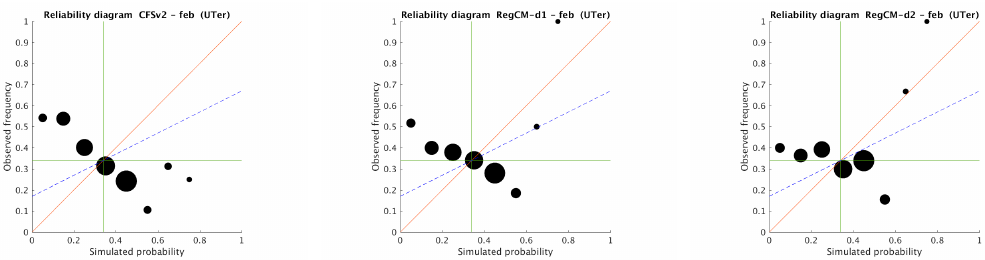
Figure 7. Cold (lower, ( a )) and warm (upper, ( b )) terciles occurrence reliability diagrams for spatial-averaged mean temperature for the climatological period (1982–2003). CFSv2 forecast system (left column), RegCM-d1 (central column), and RegCM-d2 (right column). Along the rows, December, January, and February month results respectively. Reliability diagrams plot observed event occurrence frequency conditioned to the forecast probabilities (0, ... , 1). Horizontal lines indicate climatological period simulated (observed) probability (frequency) for the considered event (cold tercile = 0.3). Blue dashed line marks diagram area positively contributing the Brier skill score. The size of the circles is proportional to the number of the occurrence of the forecast probability bin.